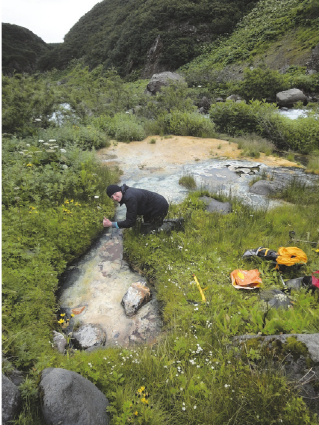
Figure 26: Isotovsky mineral hot spring (IS), August 2015. Photo by A. V. Kiryukhin.